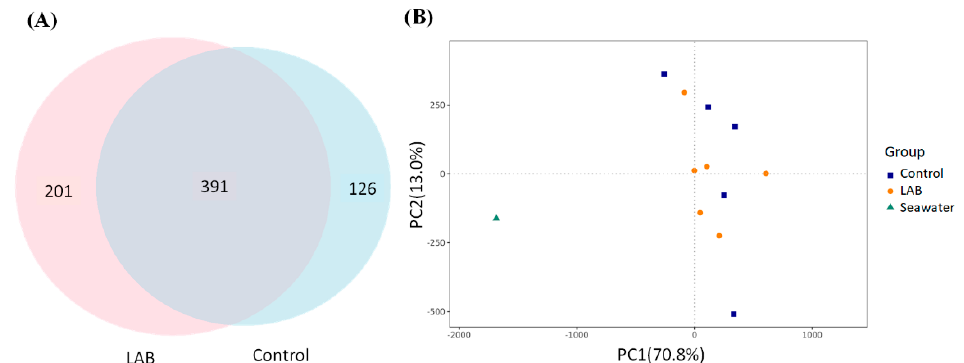
Figure 3. Expression levels of LGBP ( A ), PPAF ( B ), HSP70 ( C ), and GPx ( D ) in the hepato- pancreas of L. vannamei shrimp fed with LAB feed containing L. fermentum SWP-AFFS02 as determined by RT qPCR. Significant difference is shown by different letters (a, b) ( p < 0.05) between control and LAB feed groups.